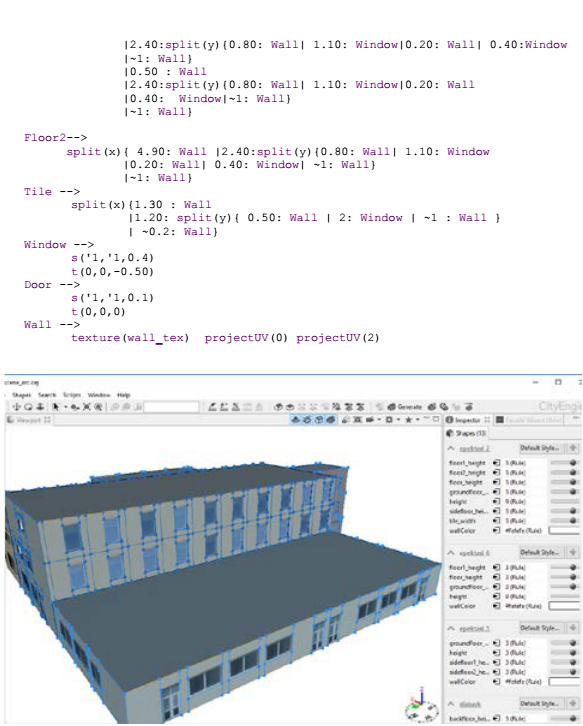
Figure 2. Part of Lampadarios building in